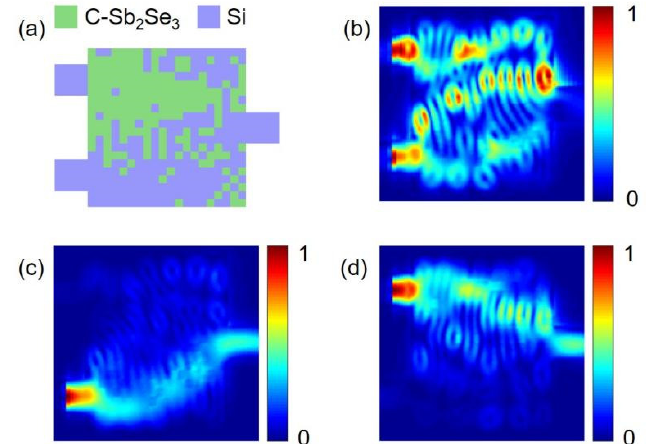
Figure 3. Energy density distribution of the XOR gate when Sb 2 Se 3 is in the crystalline state. ( a ) The final structure of our device; the green pixels are crystalline Sb 2 Se 3 and the purple pixels are silicon; ( b ) Energy distribution when the input state is ‘11’; ( c ) Input state is ‘01’; ( d ) Input state is ‘10’.